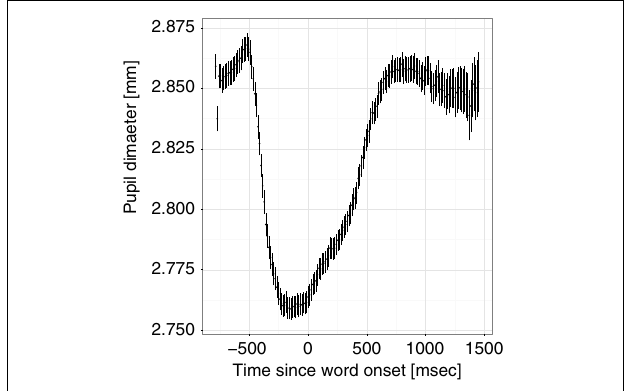
FIGURE 2 | Grand average of the pupil diameter over the course of a trial. Zero marks the onset of the target word. Vertical lines around means show the standard error for each